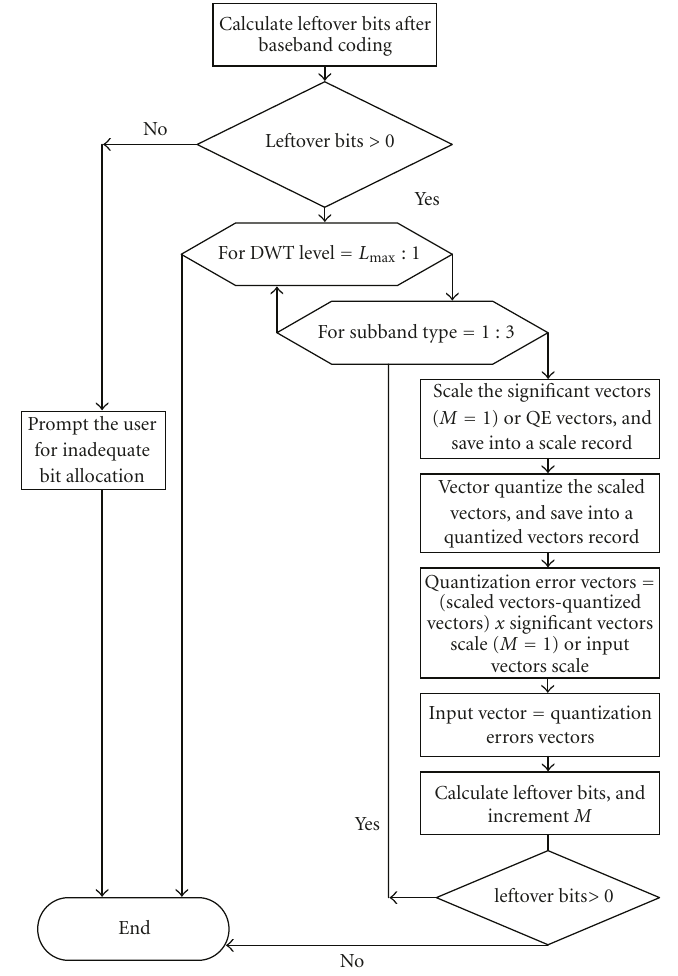
Figure 5: Flow diagram of MLVQ